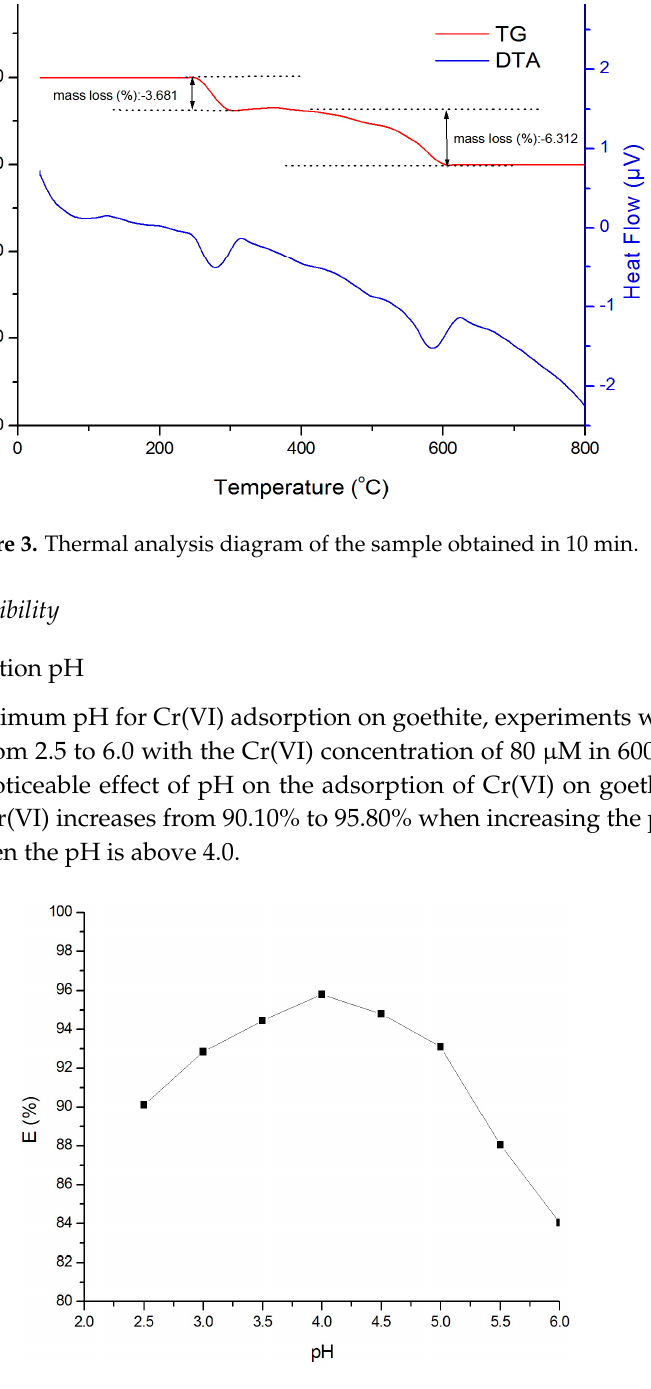
Figure 4. Adsorption of Cr(VI) on goethite at different pH values.